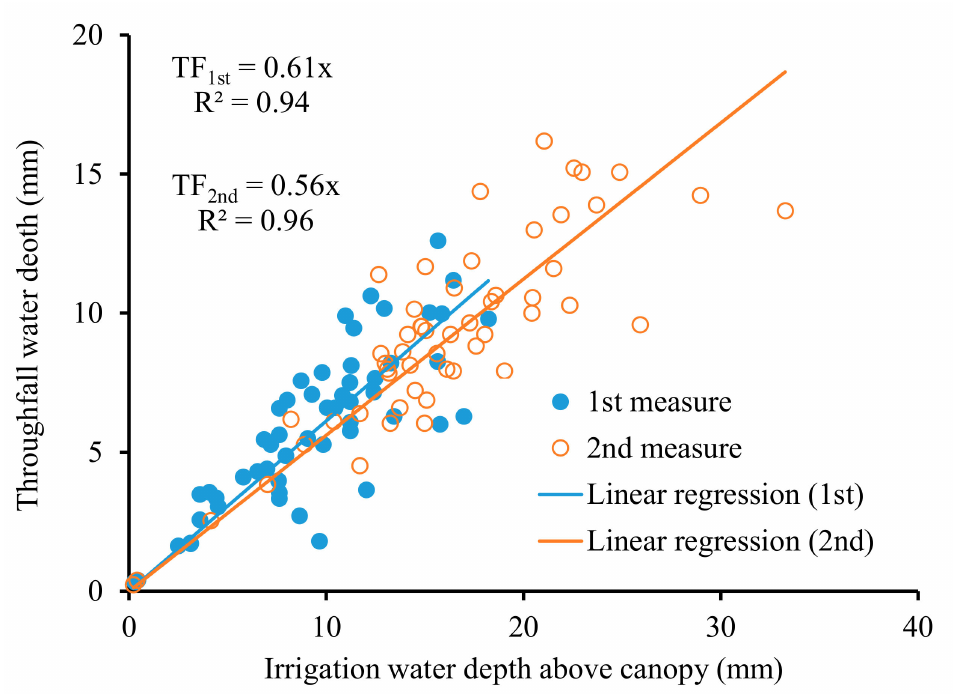
Figure 7. Throughfall water and the corresponding irrigation water depth above the canopy at the same site in the first and second measurements. TF 1st and TF 2nd represent the throughfall variable in the first and second measurements in the regression lines, respectively. When the water depths of CI, SF and TF were summed up, its total was 0.87–1.1 with a mean of 0.96 times the water depth above the